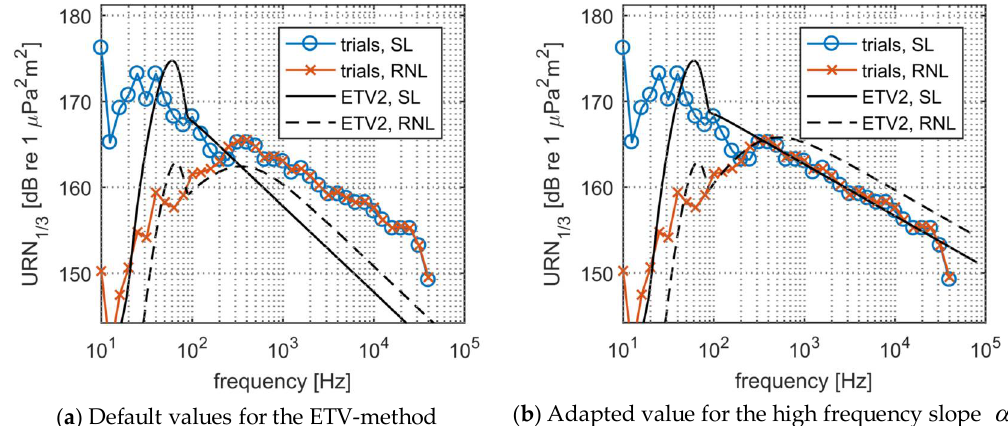
Figure 16. Measured and predicted radiated noise spectrum in one-third octave band levels for the cruise vessel at a ship speed of 18 knots. Experimental data by Kipple [45].